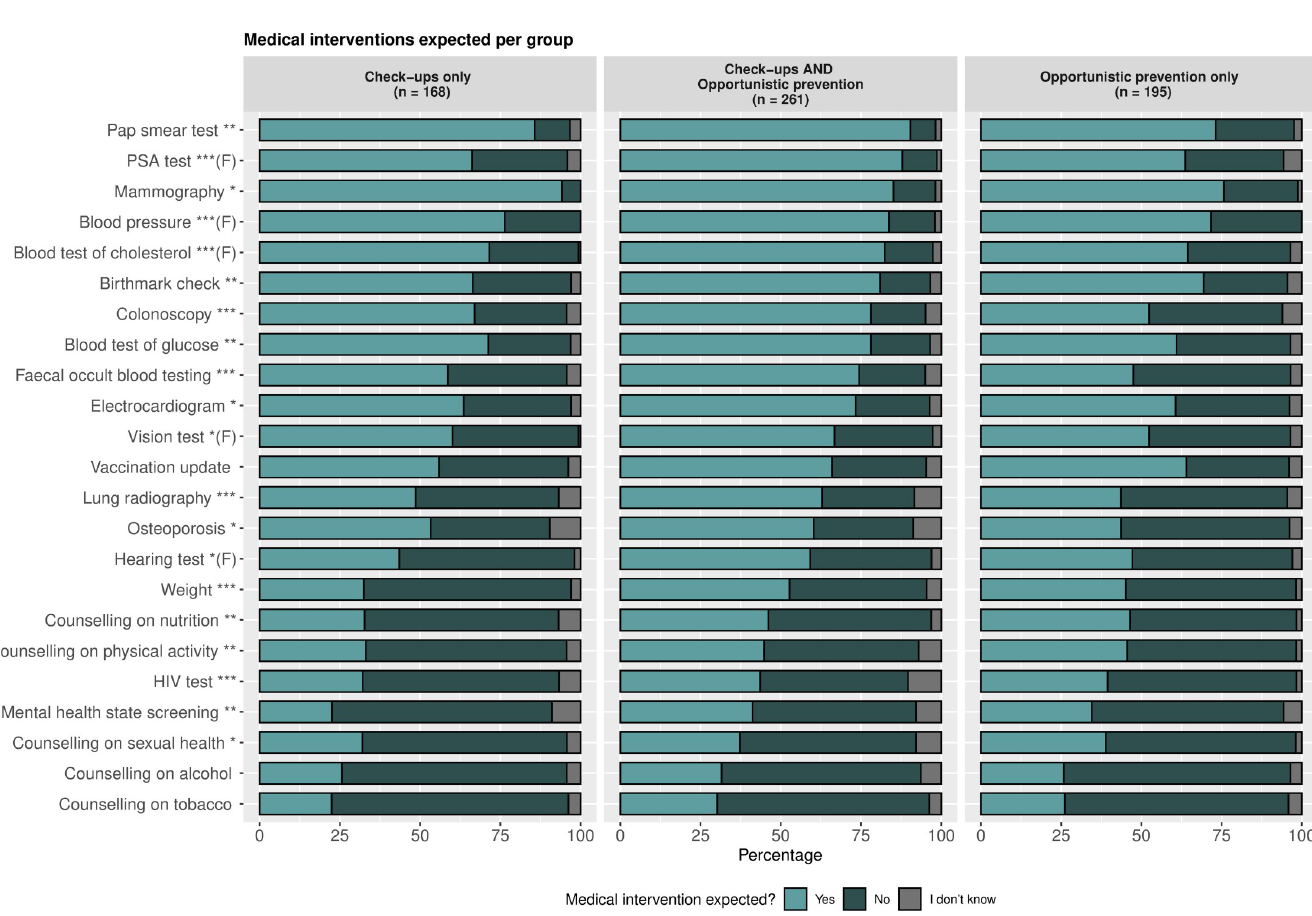
Fig 3. Medical interventions per group. The expectation for each medical intervention for participants expecting only check-ups, participants expecting check-ups and opportunistic prevention, and participants expecting only opportunistic prevention. Significant differences per each medical intervention were calculated with Chi- square t, or Fishers exact test when necessary (marked with (F) next to the medical intervention). Pap smear test = Papanicolau smear test for cervical cancer screening. PSA test = Prostate Specific Antigen blood test. � P value < 0.05, �� P value < 0.01, ��� P value <